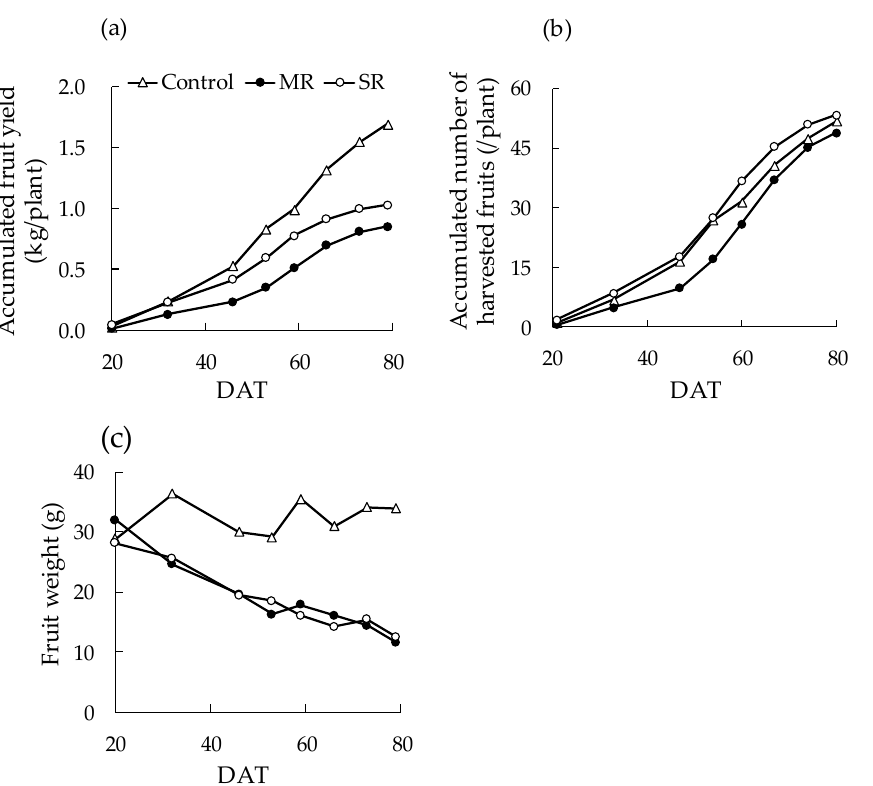
Figure 7. Effects of water stress on accumulated fruit yield ( a ), accumulated number of harvested fruits ( b ), and fruit weight ( c ) of tomatoes. In each treatment, fruits were harvested from 5–12 tomato plants at eight time points (20, 32, 46, 53, 59, 66, 73, and 79 days after commencing treatments (DAT)) throughout the experiment. MR: moderate wilting–full recovery treatment; SR: severe wilting–full recovery treatment.